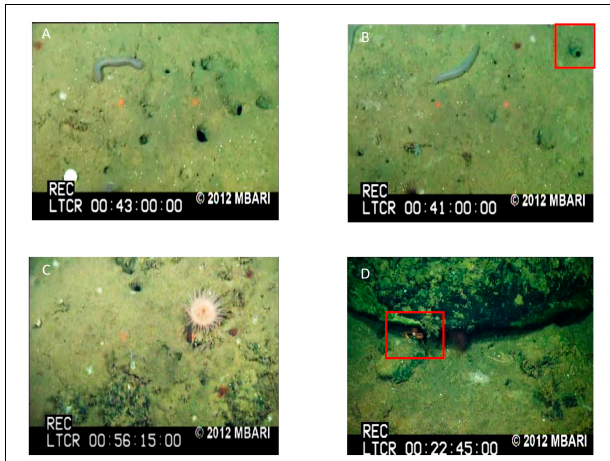
FIGURE 5 | Seafloor images showing sub-habitats identified during the transects performed between 849 and 990 m depth in Dive D347 in the NW limit of Guaymas Basin and the Sonoran Margin within the oxygen minimum zone (OMZ). (A) Structure-forming cold-water corals (CWC (cid:48) s) (antipatharians and alcyonarians) on rocky outcrops in the lower OMZ transitional zone. (B) Structure-forming sponges in the lower OMZ transitional zone that provide a refuge from predators and an enhanced food supply for diverse species. Note a decapod crustacean living in the atrium of sponge. (C) CWC (cid:48) s on rocky outcrops that provided an elevated position for spider crabs ( Gastroptychus ) in the lower OMZ transitional zone and in the lower boundary of the OMZ core. (D) Oyster (Pectinidae) aggregations that provide with their shell a hard substrate for the attachment of solitary corals and alcyonarians. This type of habitat was observed all along the lower boundary of the OMZ core. Note that these aggregations also allow the association of solitary corals in their surroundings. Images courtesy of